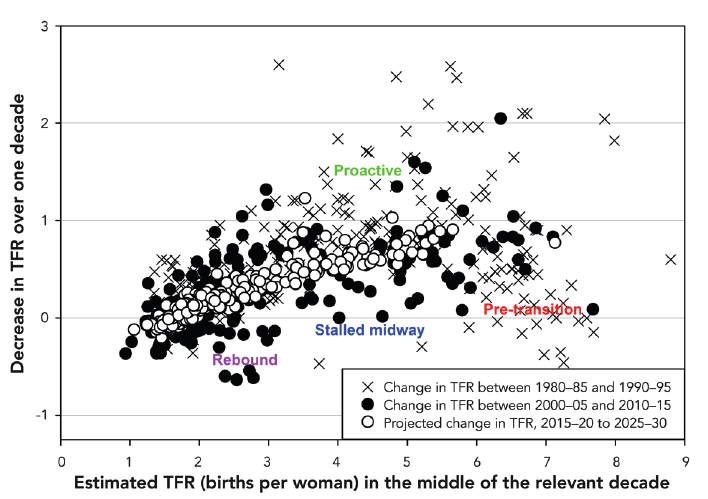
Figure 3. The relationship between the fertility rate of each country and the rate at which its fertility falls, for the most recent decade (black dots), compared with the first projected decade (open dots) and with the 1980s (crosses). Over time, the fertility of individual countries undergoing fertility transition moves from right to left. The projections depend on what is anticipated to be the average pathway, the variation around that average pathway, and when each country embarks on their